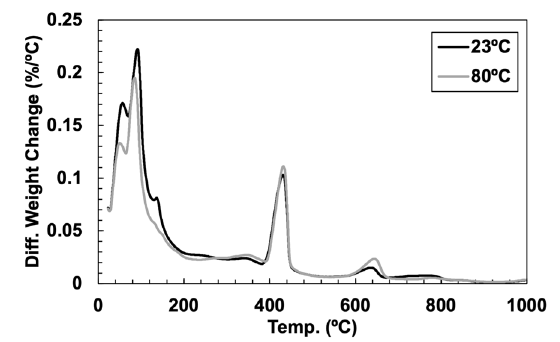
Figure A2. TGA results for HA mixture with different curing regimes.